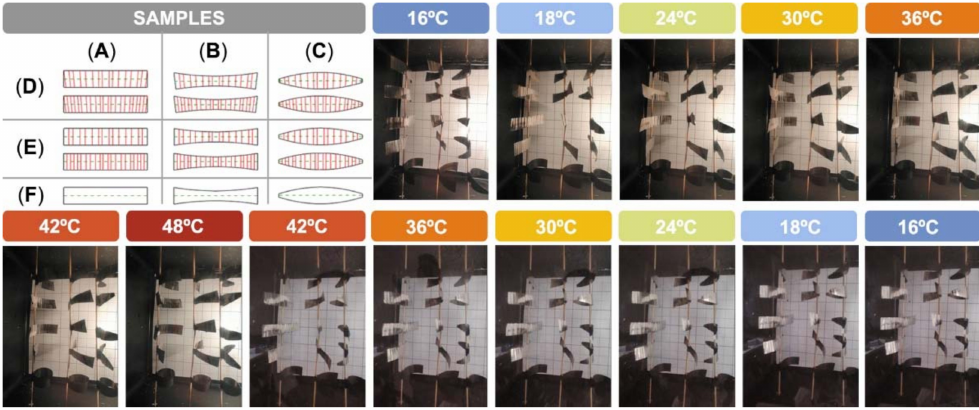
Figure 14. Experiment variants subjected to different temperatures. The bimetal samples were on a wooden support, as in ( A – C ). Sample table lines: different sample types: ( D ) oblique crease; ( E ) perpendicular crease; ( F ) control sample. Source: